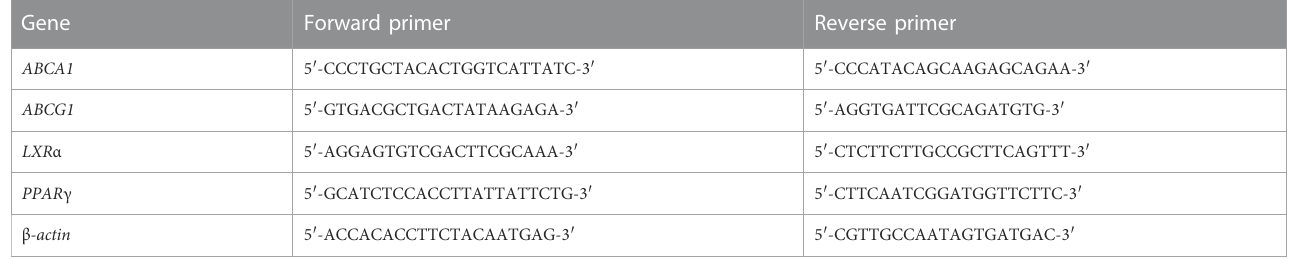
TABLE 1 Primers for real-time quantitative PCR.